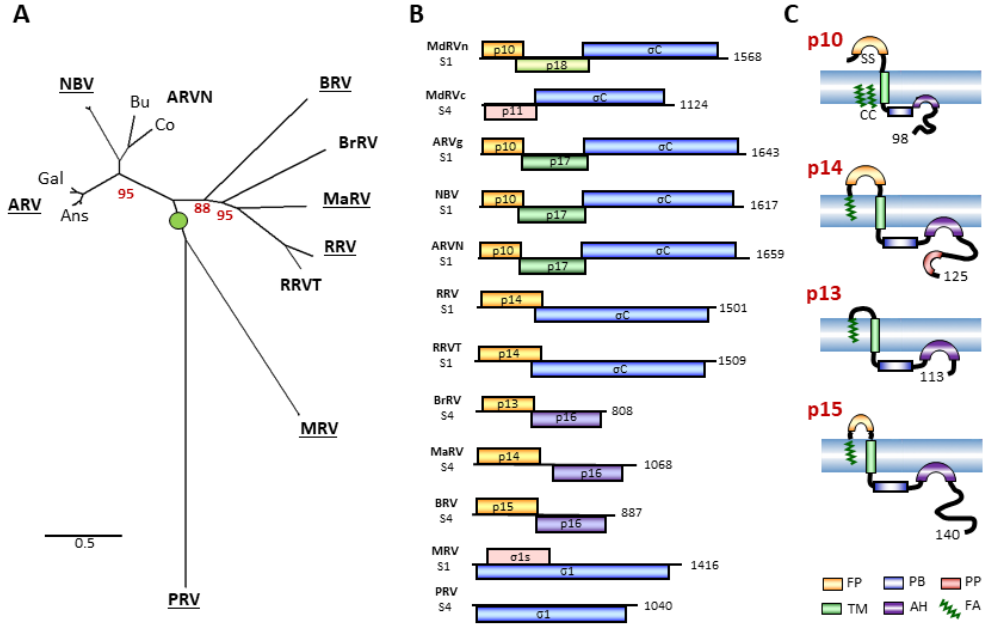
Figure 1. The diversity of orthoreovirus species, their polycistronic genome segments, and their fusion-associated small transmembrane (FAST) proteins. ( A ) Maximum likelihood unrooted phylogram based on 23 concatenated amino acid sequences of the seven consistently homologous structural proteins (core shell, core RdRp, core turret, core NTPase, core clamp, outer-shell, outer-clamp) encoded by the indicated 10 species or proposed species of orthoreoviruses (in boldface). See Supplementary Table S1 for a list of viruses, proteins, and accession numbers. Lowercase labels denote isolates within a species: Gal and Ans are landfowl and waterfowl isolates of avian orthoreovirus (ARV); Bu and Co are bulbul and corvid isolates of neoavian orthoreovirus (ARVN). Bootstrap values (500 replicates) are shown for branch points where the associated taxa clustered together in less than 100% of the replicate trees. The tree with the highest log likelihood is shown. Branch lengths are to scale and measured by the number of substitutions per site. ( B ) Diagrams of the polycistronic S1 and S4 genome segments from the indicated orthoreovirus species, drawn to approximate scale. Open reading frames are depicted by rectangles, labeled to indicate the protein product and color-coded to depict functional or evolutionary protein relationships: yellow—FAST protein; blue—fiber protein; green—potential cell cycle inhibitory protein; purple—homologous proteins with no defined function; pink—nucleocytoplasmic shuttling protein. Numbers refer to mRNA length. ( C ) Diagrams of the orthoreovirus FAST proteins, depicting their topology in the plasma membrane. Structural motifs contained within their N-terminal ectodomains and C-terminal cytoplasmic endodomains are color-coded as described in the legend at the bottom. Numbers indicate the number of residues in each protein.